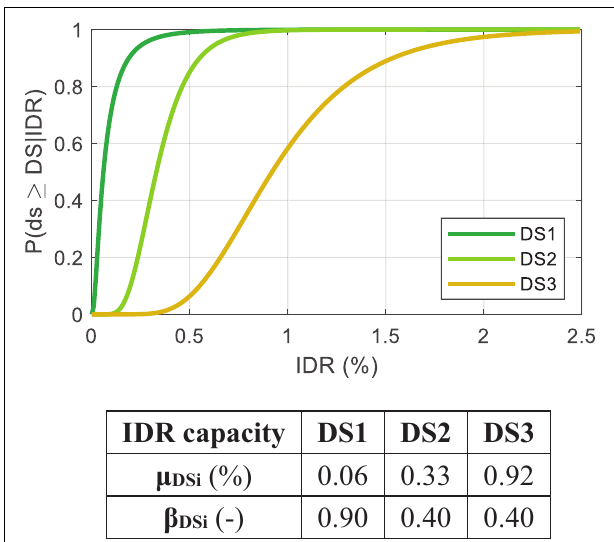
FIGURE 2 | Drift-based fragility curves; mean ( µ DSi ) and logarithmic standard deviation ( β DSi ) of IDR capacity at each DS for weak hollow clay masonry infill.